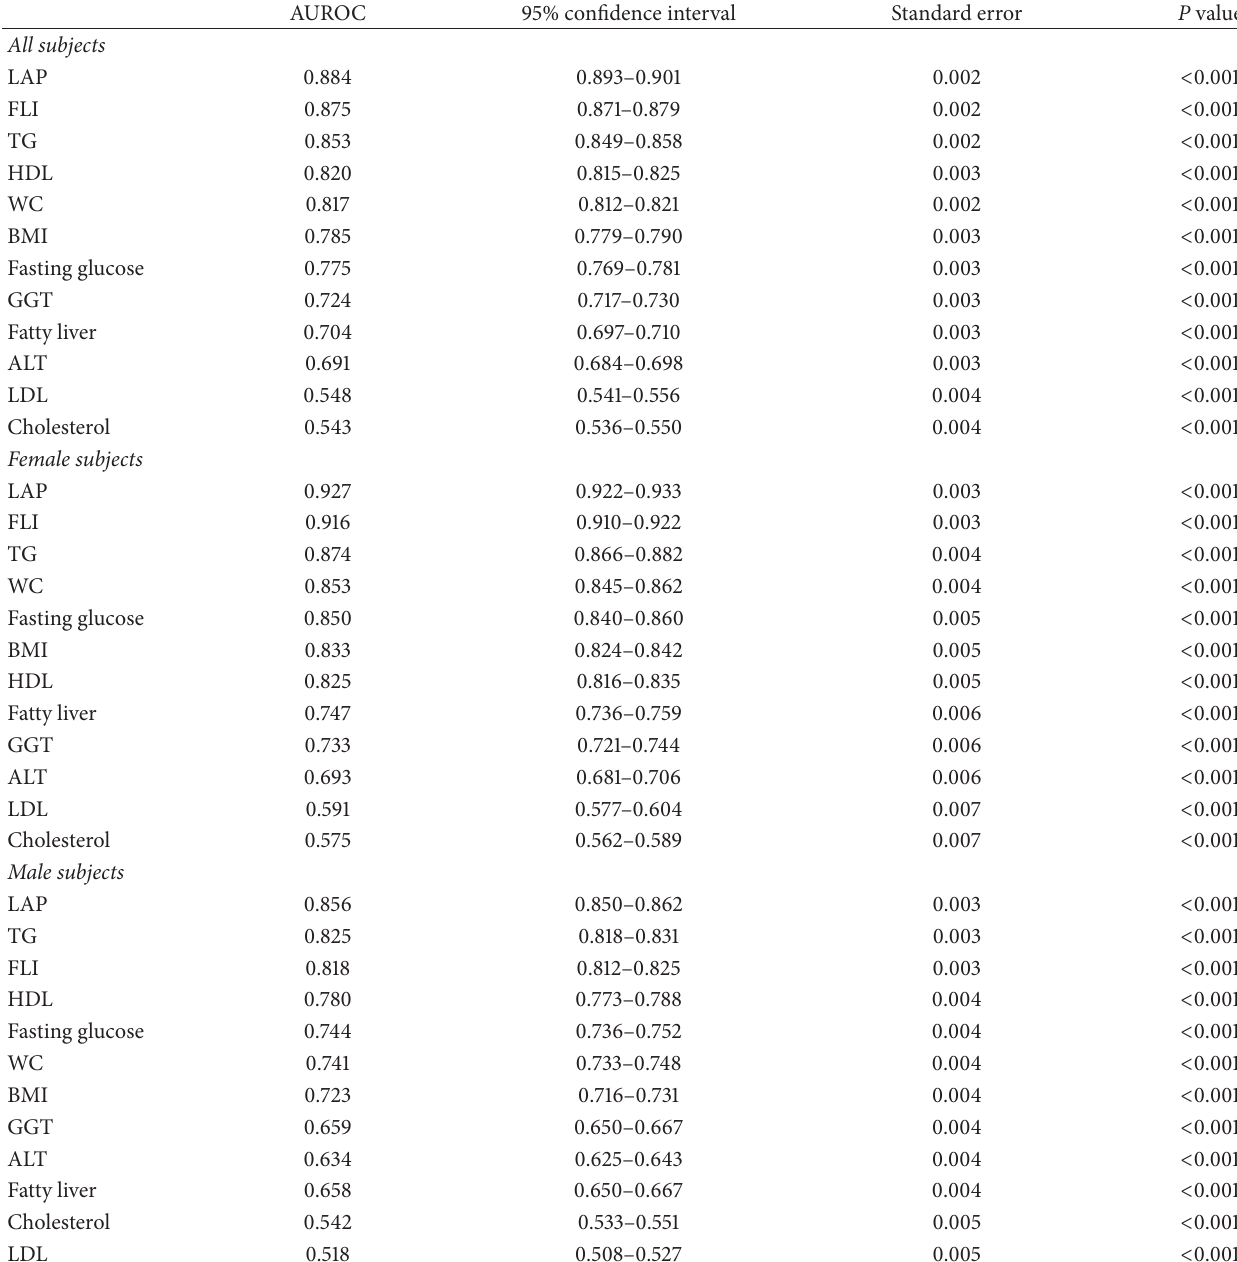
Table 3: Comparison of AUROC curve values among noninvasive markers for predicting metabolic